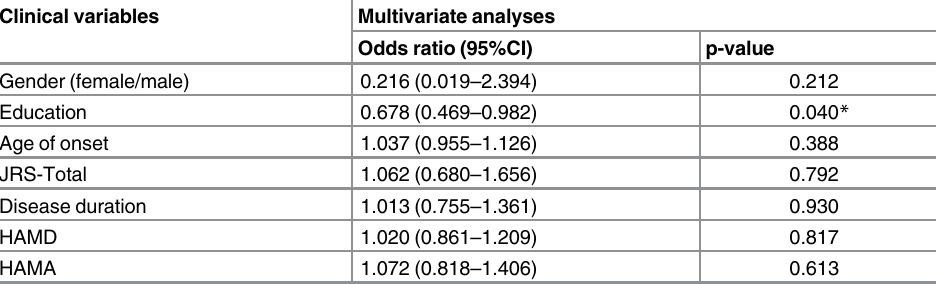
Table 5. Determinants of cognitive impairments based on the ACE-R cut-off score ( < 80) (Data were from those fifty patients not in receipt of oral medication.). Clinical